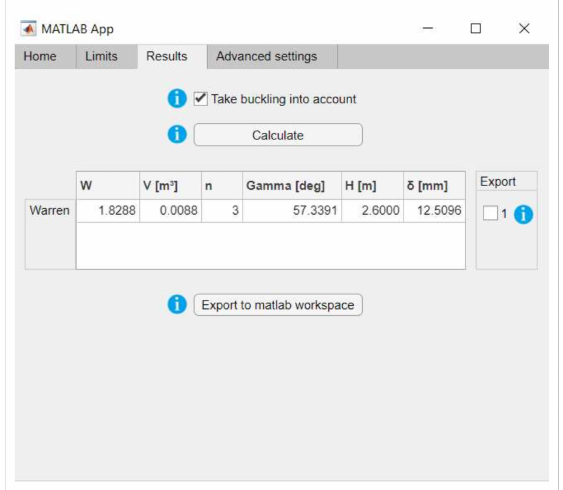
Figure 2. Software limits tab.